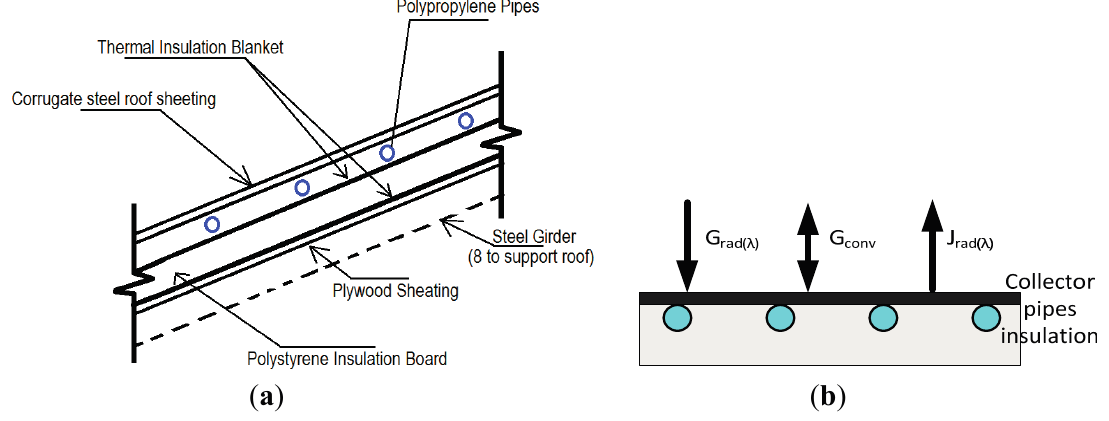
Figure 2. ( a ) Thermal solar collector scheme; ( b ) Energy balance in the collector